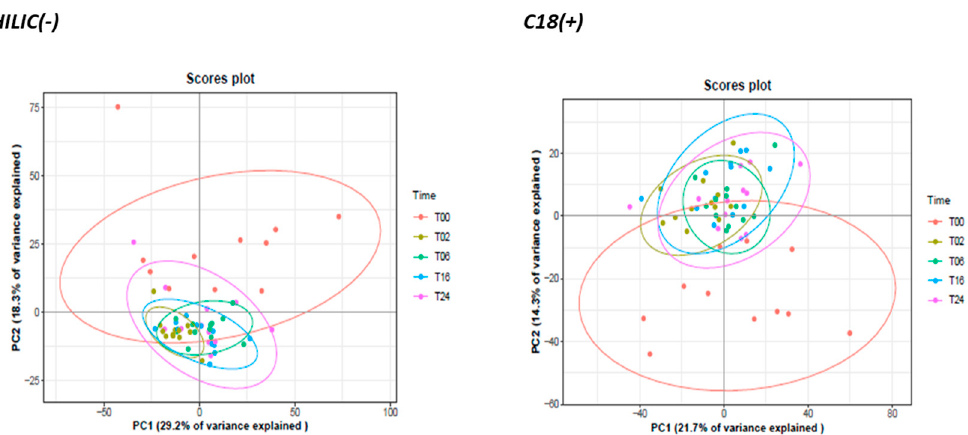
Figure 6. Principal component analysis (PCA) of all detected variables across time in HILIC ( − ) and C18 (+) analytical conditions. Data were Log10 − transformed before PCA.